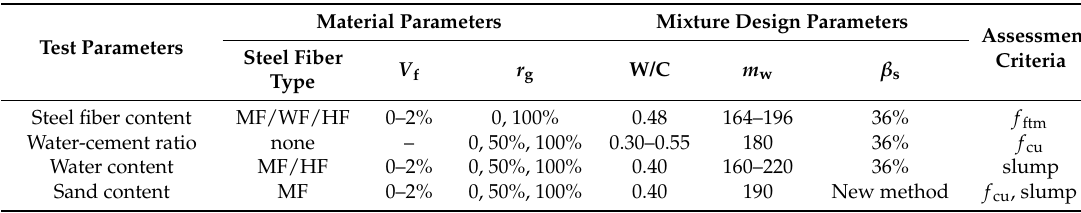
Table 3. Test plan and parameters.